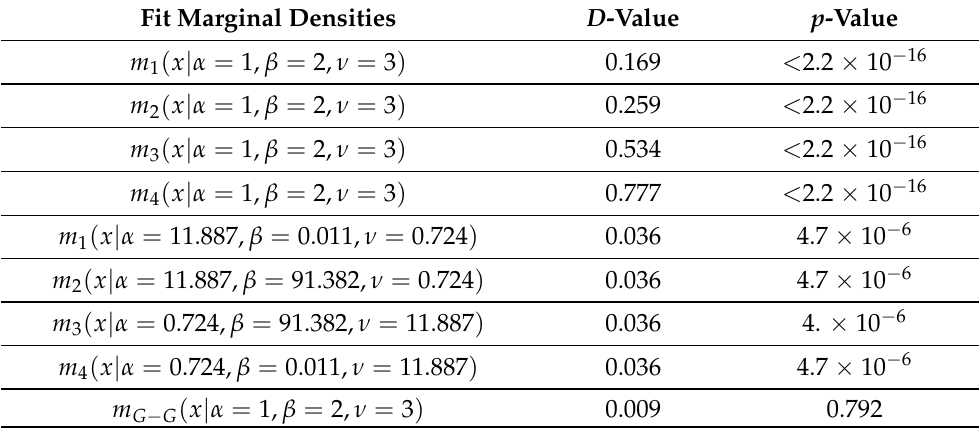
Table 3. The fit marginal densities, D -values, and p-values of the one-sample KS test for a sample with sample size n = 5000 from the hierarchical G ( ν , θ ) − G ( α , β ) model when α = 1, β = 2, and ν = 3.